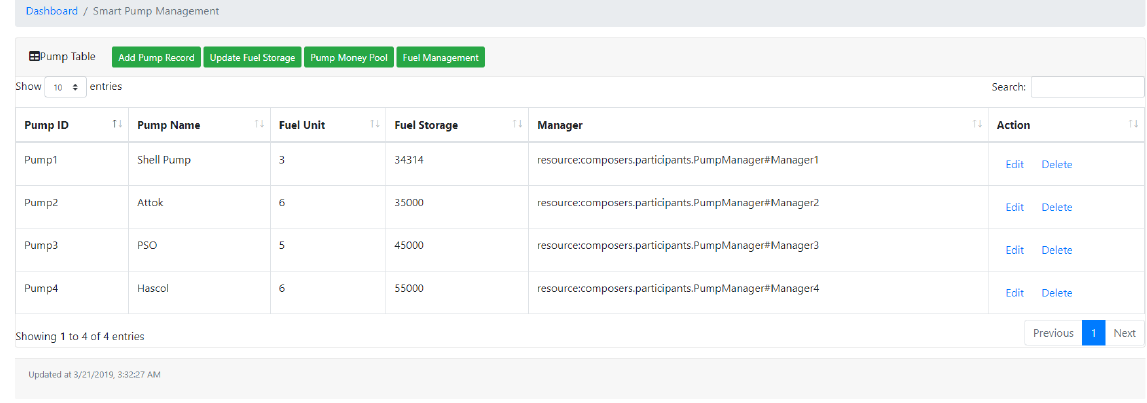
Figure 11. Pump management